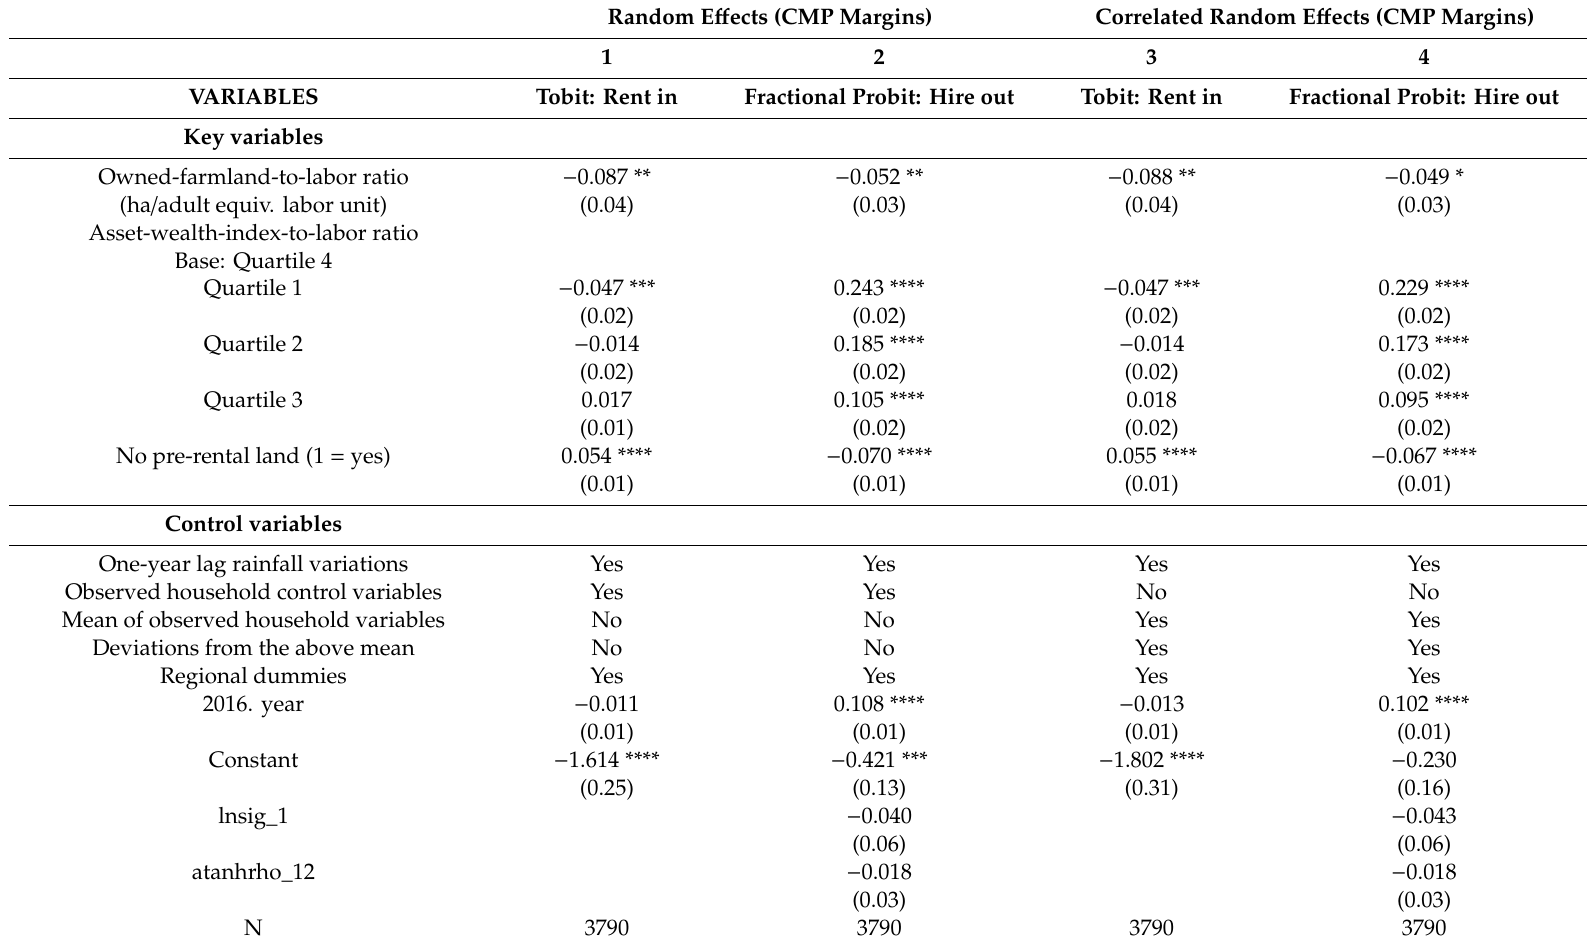
Table 4. Conditional mixed process (CMP) margins from a systems approach using Tobit for the land rental markets and fractional probit for the share of adult equivalent labor hired out for casual work ( ganyu